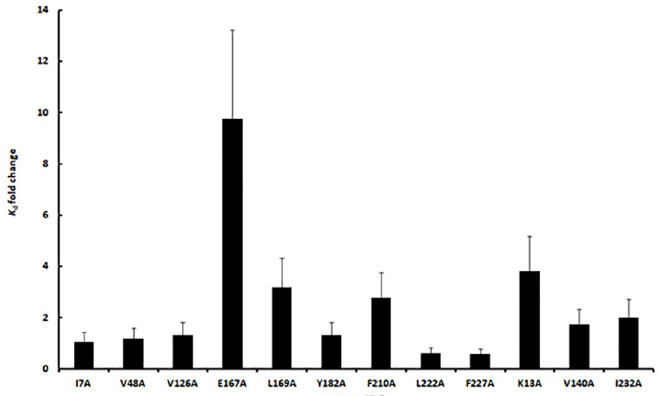
Fig 8. Effect of HisF mutations on the dissociation constant ( K d ) of the HisF-HisH heterodimer. Experiments were performed at 30˚C. Error bars were based on the relative deviation of the dissociation constant in the experiments using the wild-type HisF (n = 6). Mutant HisF subunits are identified by the single residue exchange present on them.